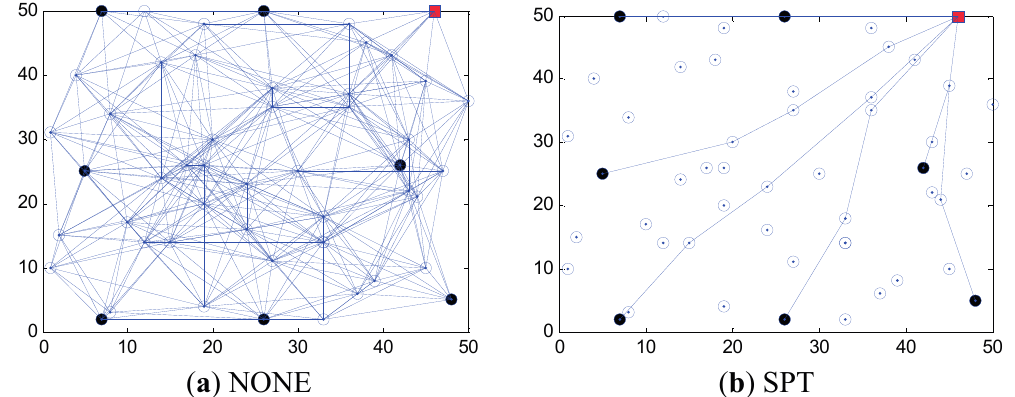
Figure 5. Routing tree